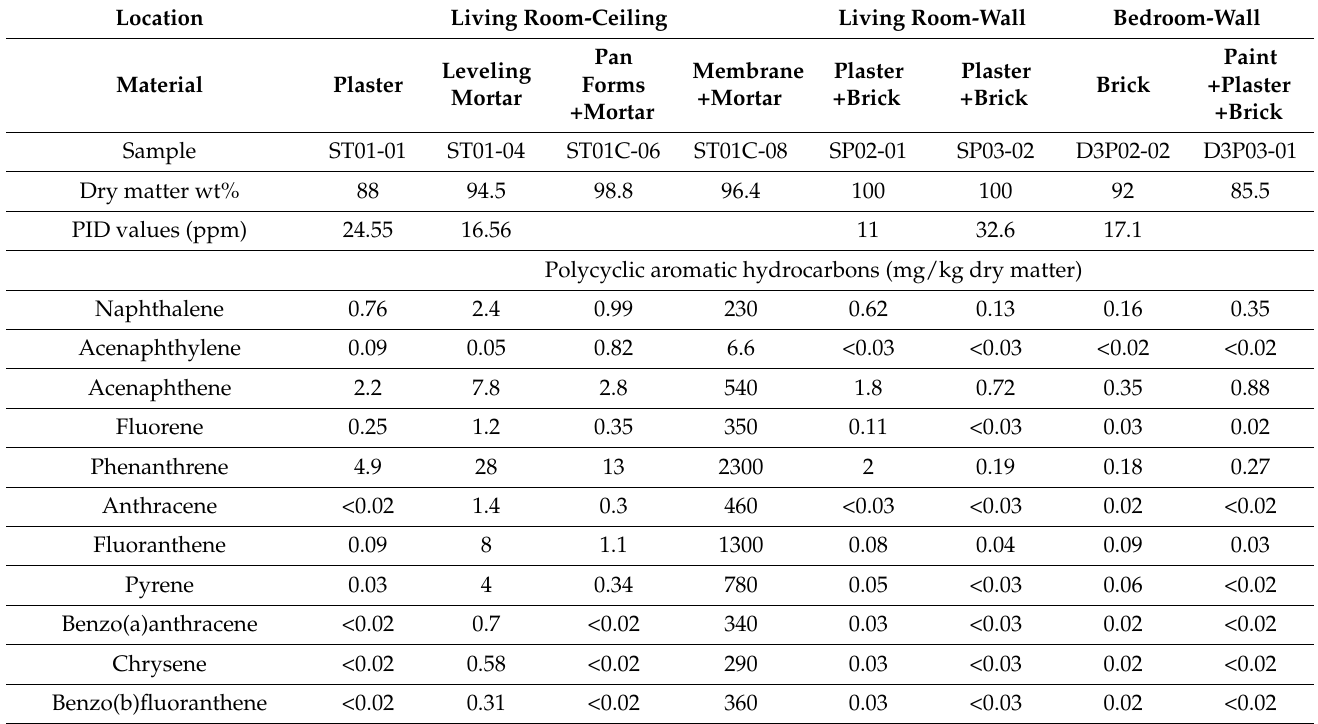
Table 5. VOC and SVOC concentrations in the construction